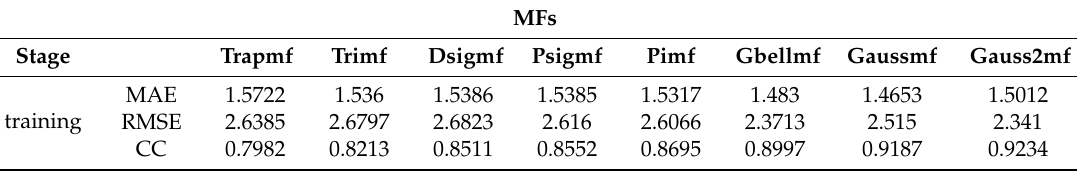
Figure 11. S11 obtained from the whole possible cases simulated by High Frequency Electromagnetic Field Simulation software (HFSS). Table 4. Results of the adaptive network-based fuzzy inference system (ANFIS) tested with different membership functions.